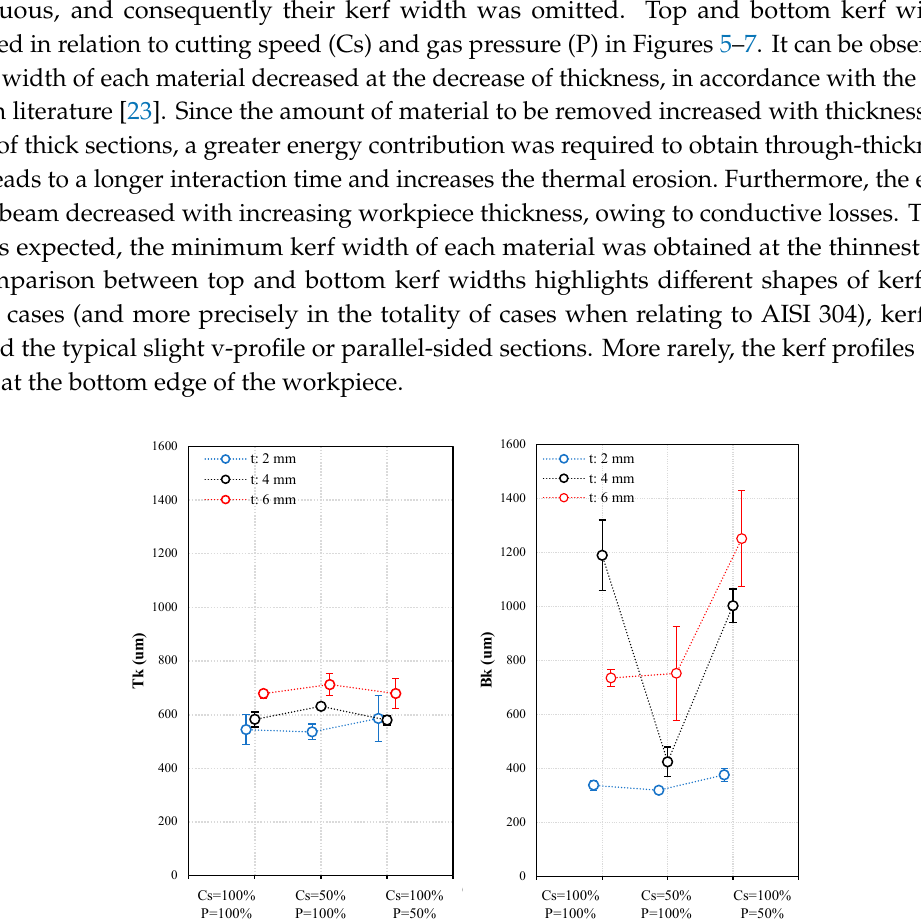
Figure 4. Schematic of profile acquisition.